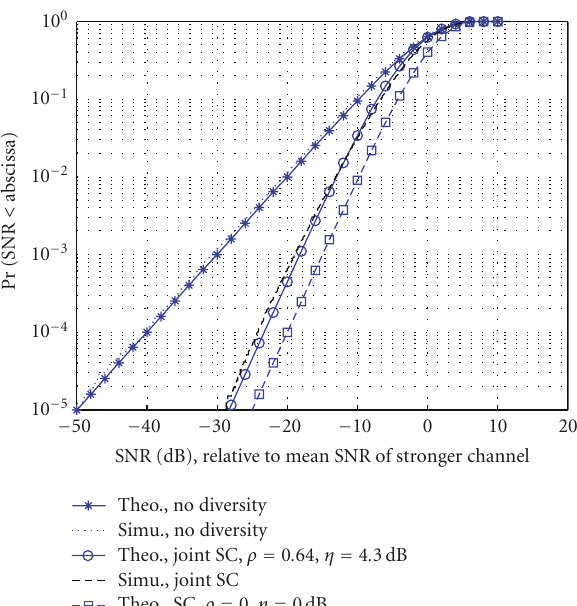
Figure 9: The outage rates of di ff erent channels using directional antennas at both ends of the wireless